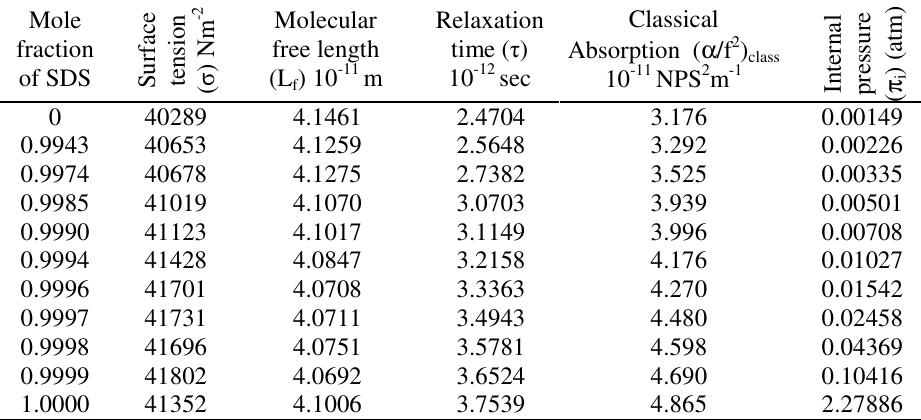
), relaxation time( τ ), f ) of sodium dodecyl sulphate (SDS) i